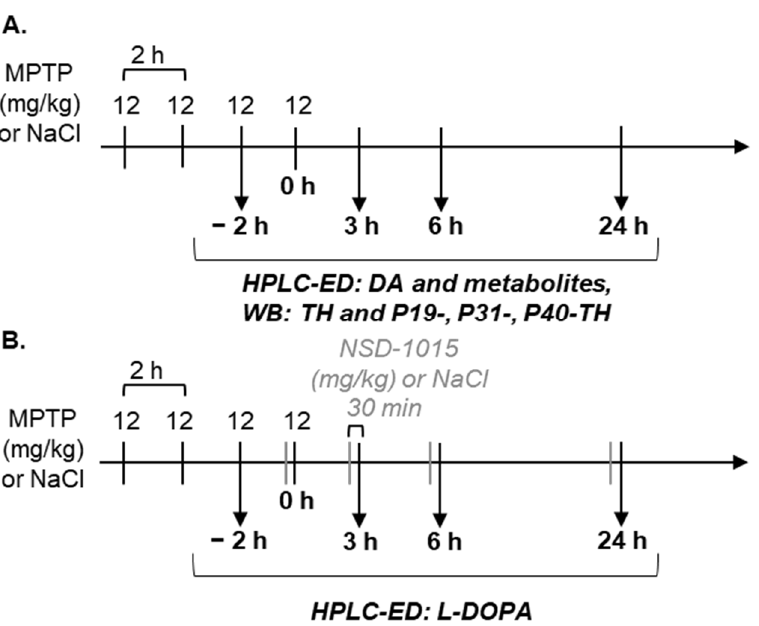
Figure 1. The scheme of the experiments for assessing: ( A ) the concentration of DA in the striatum as well as the content of TH and its phosphorylated forms at serine at positions P19-, P31-, and P40-TH and ( B ) the activity of TH during inhibition of DAA in the striatum and substantia nigra during the period of neurodegeneration (from − 2 h to 6 h after MPTP injections) and neuroplasticity (24 h) in the nigrostriatal system in an early clinical PD model. DA—dopamine, HPLC-ED—high-performance liquid chromatography with electrochemical detection; L-DOPA—L-3,4-dihydroxyphenylalanine; MPTP—1-methyl-4-phenyl-1,2,3,6-tetrahydropyridine; NSD-1015—3-hydroxybenzylhydrazine; TH— tyrosine hydroxylase; SN—substantia nigra, WB—Western